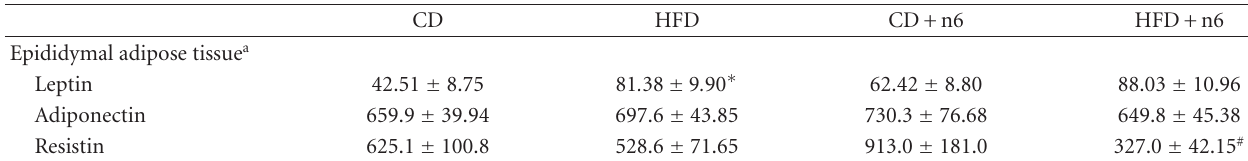
Table 3: Adipokine production in adipose tissue from mice fed with control diet (CD) or high-fat diet (HFD), supplemented, or not with sunflower oil (rich in n-6 fatty